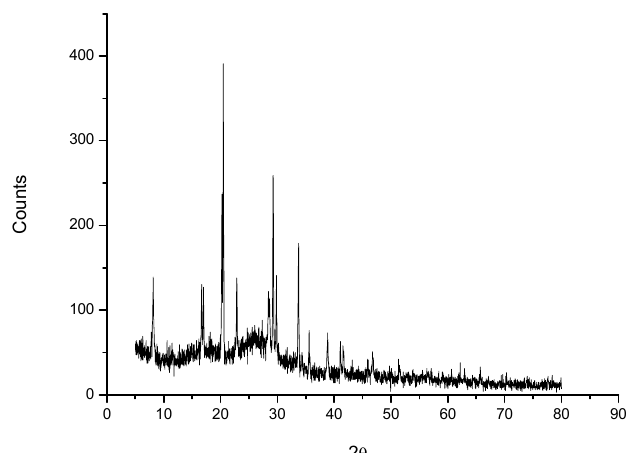
Figure 5. XRD of the solid oxidovanadium(IV)–AMP complex.